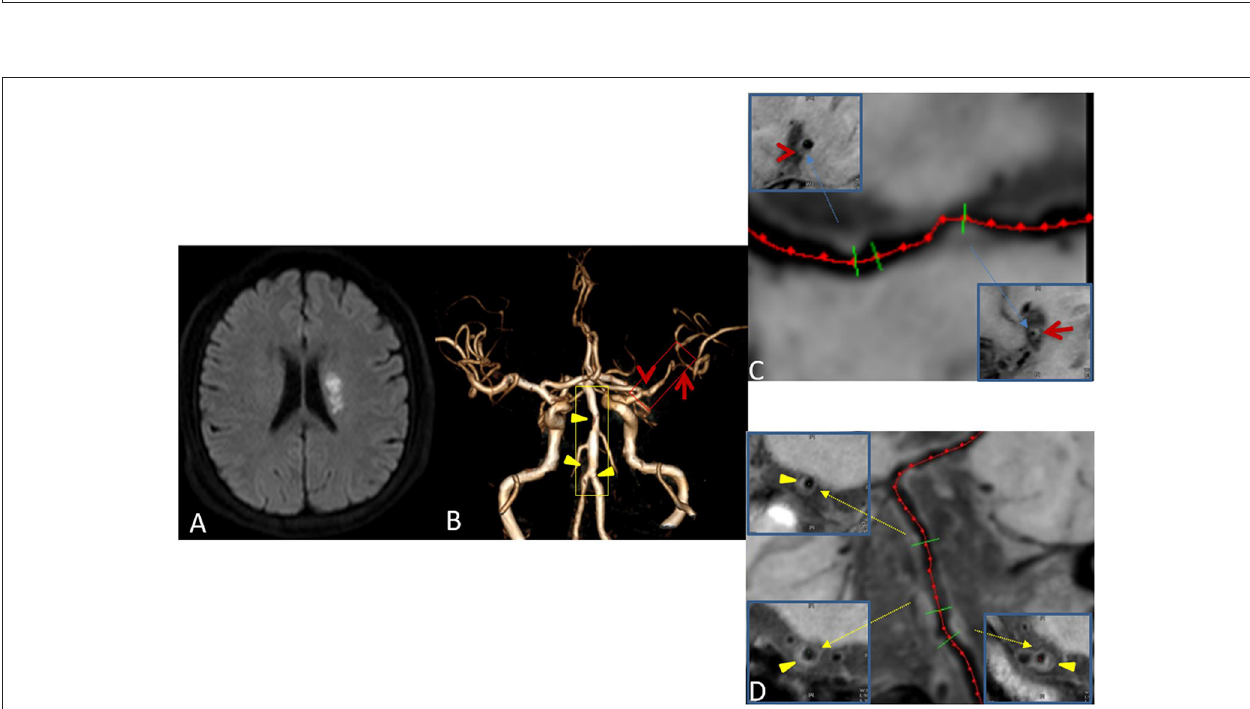
FIGURE 3 | Plaque Classification. Male, 42 years old, presenting with sudden right limb weakness for 8h. Diffusion-weighted imaging (DWI) shows acute left lateral paraventricular infarction (A) . Time-of-flight magnetic resonance angiography (TOF MRA) shows stenosis at two sites in the M1 segment of the left middle cerebral artery (red box) and three sites in the basilar and left vertebral arteries (yellow box) (B) . Curved planar reconstruction images show severe stenosis at the distal end of M1 as the culprit plaque (red arrow), and mild stenosis at the proximal end of M1 as an uncertain plaque (red Arrowhead) (C) . The three plaques of the basilar artery and left vertebral artery are non-culprit plaques (Yellow triangular arrowheads) (D) .